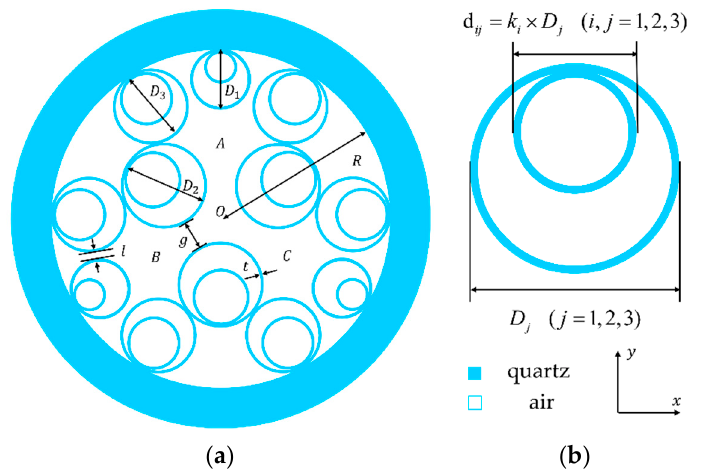
Figure 1. ( a ) Schematic diagram of the NMH-ARF structure; ( b ) Schematic diagram of the nested capillary structure .